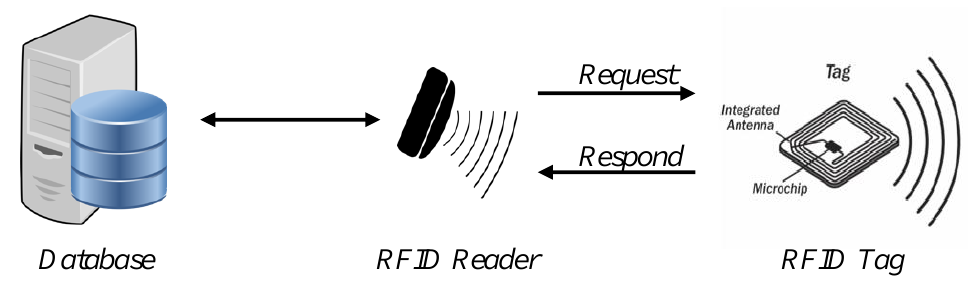
Figure 1. Basic RFID Model.